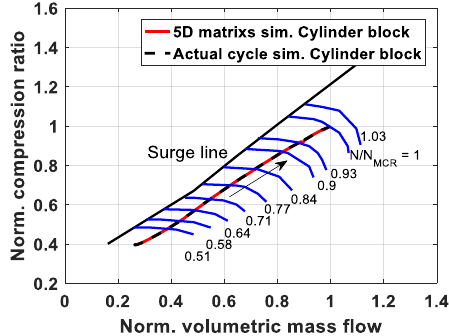
Figure 7. TC acceleration in the compressor map.